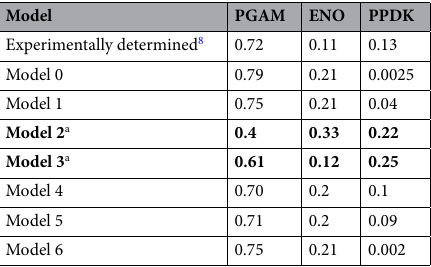
Table 8. Flux control coefficient determination. a For these models, C J E are determined manually.